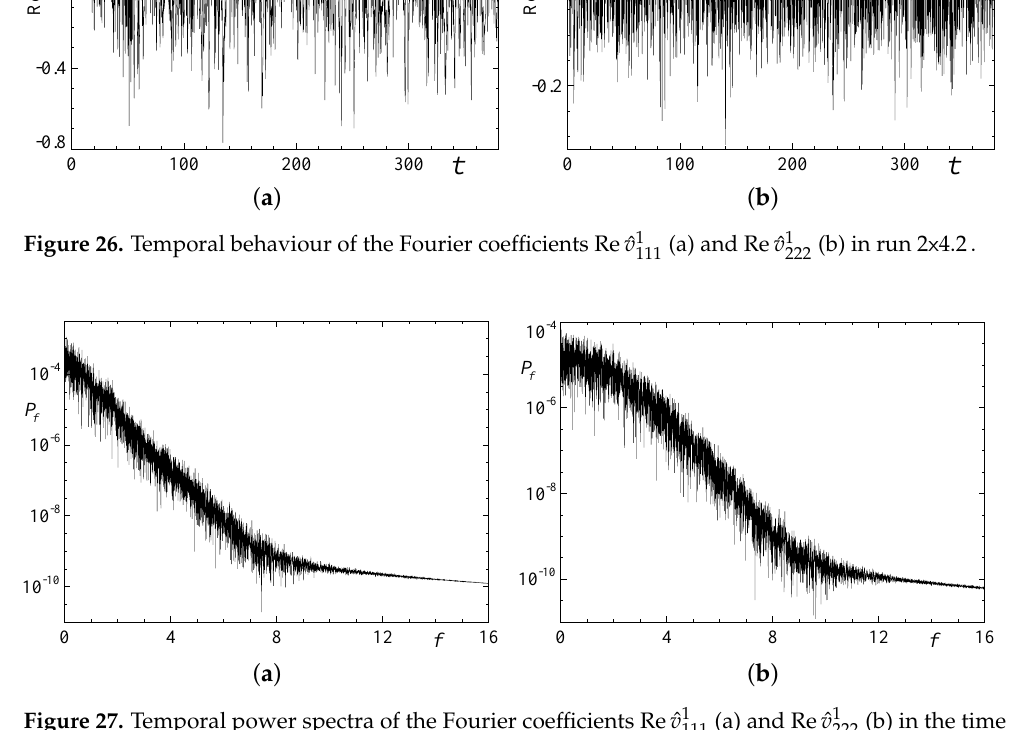
(a) and Re ˆ v 1 (b) in the time 222 111